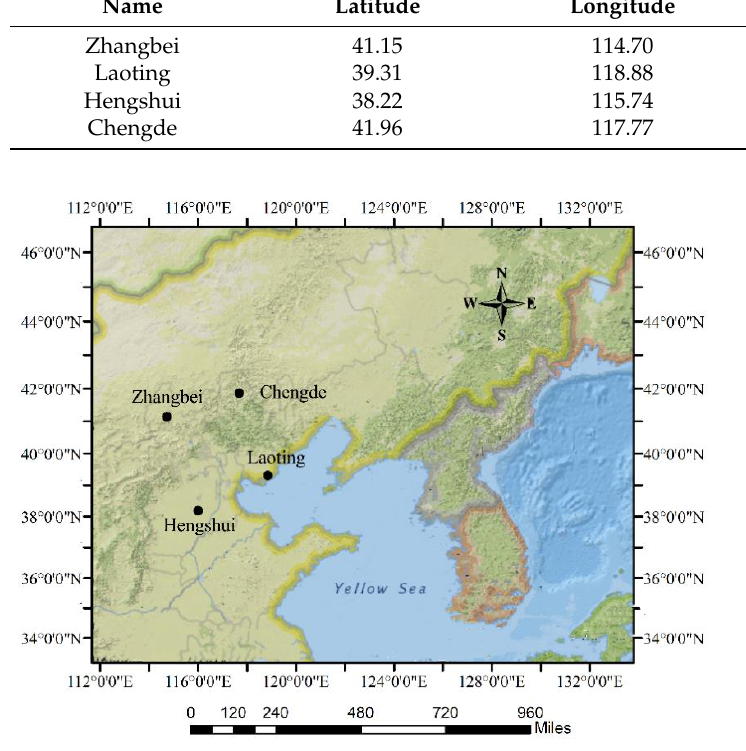
Figure 1. The study region and the locations of the ground radiation stations. Table 1. The amount of data for different weather types at the four observation points.